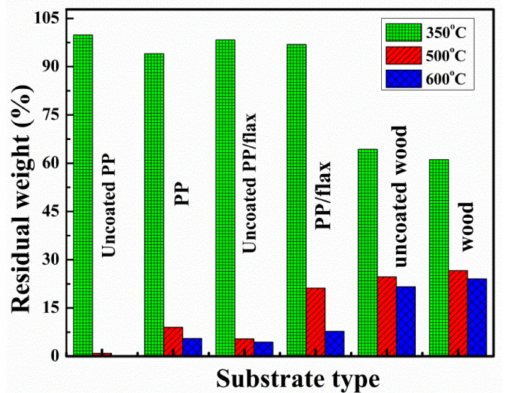
Figure 7. Comparative profile of the residue left at various temperatures during